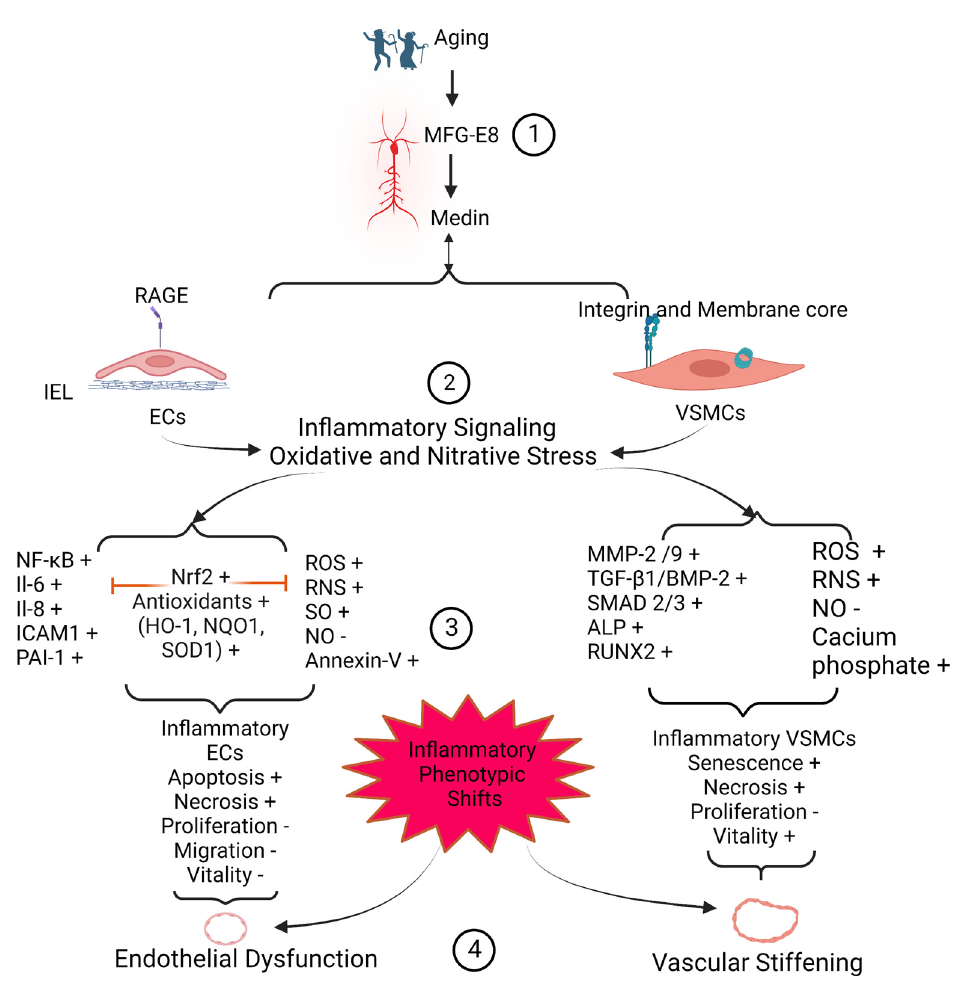
Figure 4. MFG-E8/Medin-mediated vascular cellular inflammation and vascular dysfunction. (1) Aging increases the expression of MFG-E8 and medin; (2) MFG-E8/medin activates the inflammatory reaction and oxidative stress through the RAGE receptor in endothelial cells and triggers the inflammation and oxidation in vascular smooth muscle cell via receptors integrin and oligomer medin forming the membrane pore; (3) MFG-E8/medin associated oxidative and nitrative stress and inflammation eventually leads to the apoptosis, senescence, and necrosis of both ECs and VSMCs; and (4) Vascular inflammatory phenotypic shifts cause vascular endothelial dysfunction (acetylcholine dependent dilatation decline) and vascular stiffening. Abbreviations: MFG-E8, milk fat globule EGF VIII; EC, endothelial cells; IEL, internal elastic lamina; VSMC, vascular smooth muscle cells;